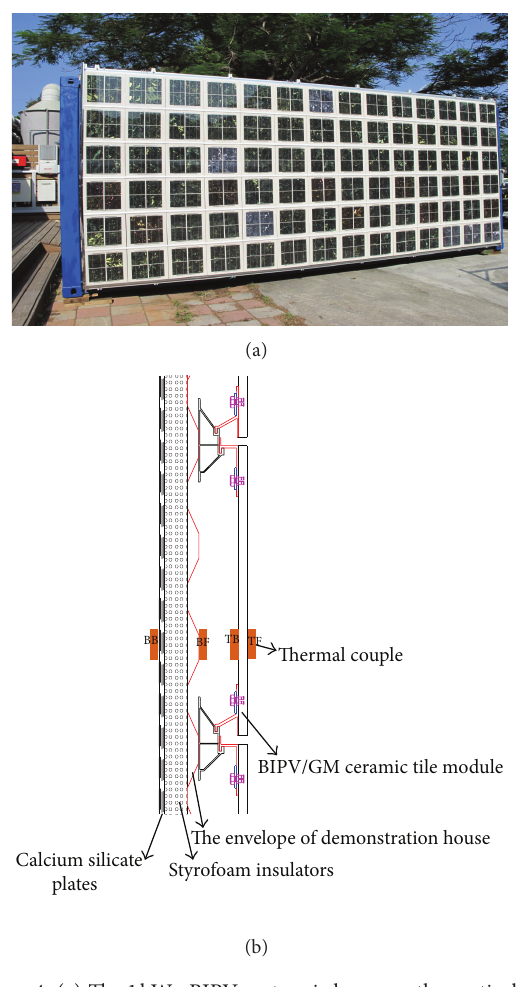
Figure 4: (a) The 1kWp BIPV system is hung on the vertical wall of the demonstration house, (b) the cross-section structure of the BIPV/GM system.